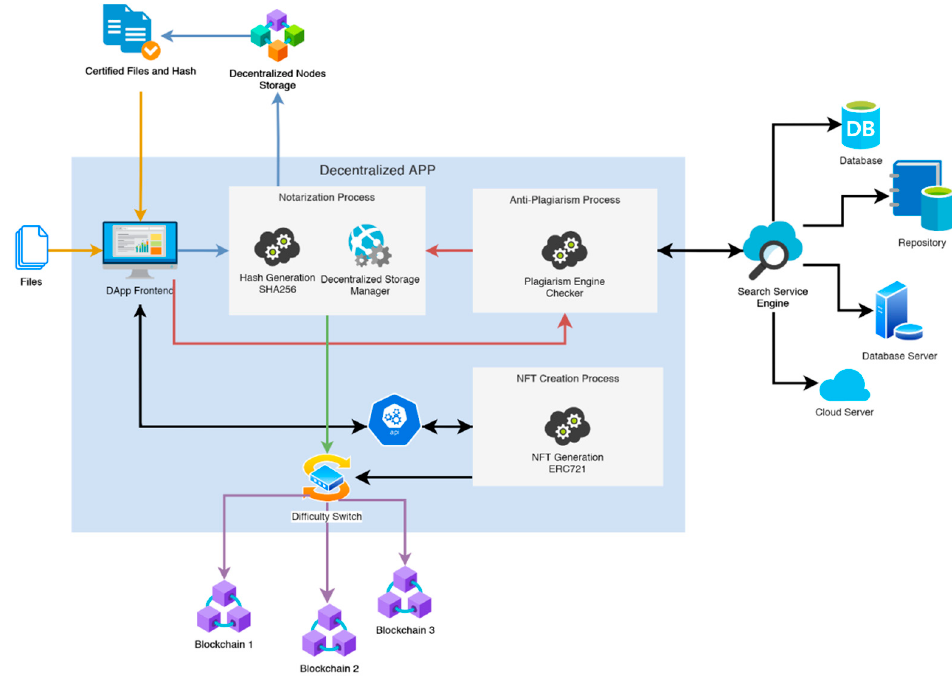
Figure 1. Proposed solution schema.